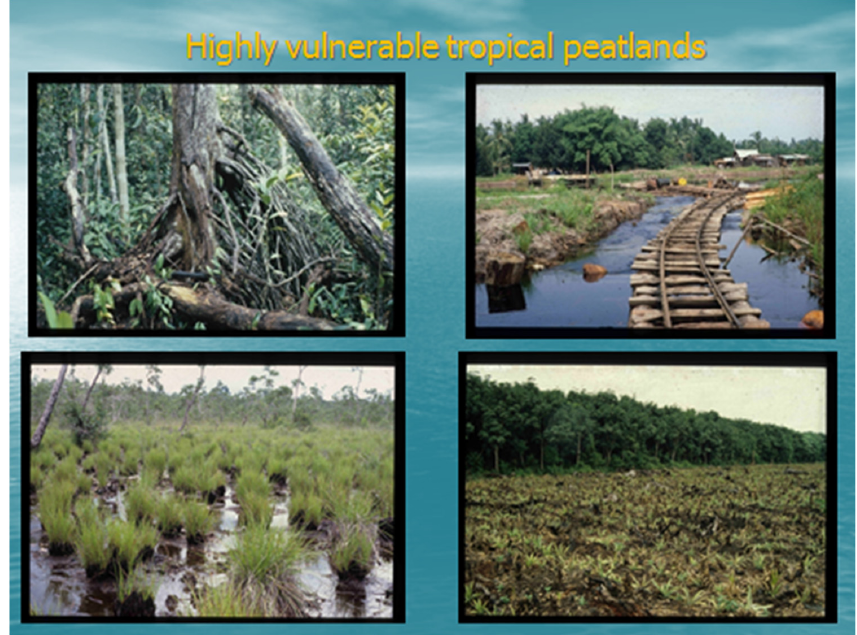
Figure 2. The complexity and rich biodiversity of intact peat swamp forest in Indonesia and examples of the simplification resulting from clearance and conversion to agriculture. Source: Edward Maltby.